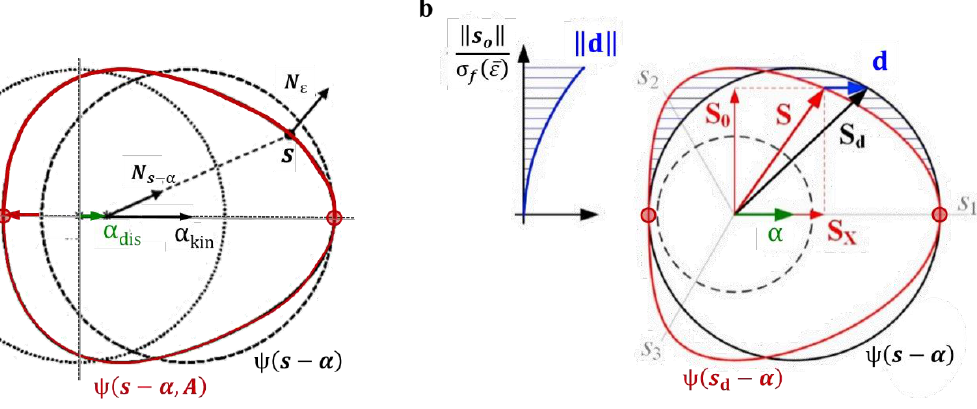
Figure 13. Schematics of the distorted yield surfaces described using the ( a ) Feigenbaum 07 and ( b ) François 01 models. Reprinted with permission from Ref. [56]. 2007, Feigenbaum, H.P. et